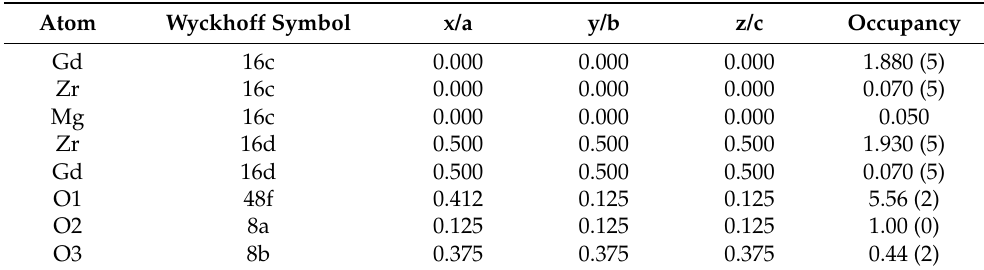
Table 2. The refined coordinates of atoms of 0.95Gd 2 Zr 2 O 7 –0.05MgO in a cubic unit cell (space group Fd-3m), with Gd and Mg existing in the A sublattice.